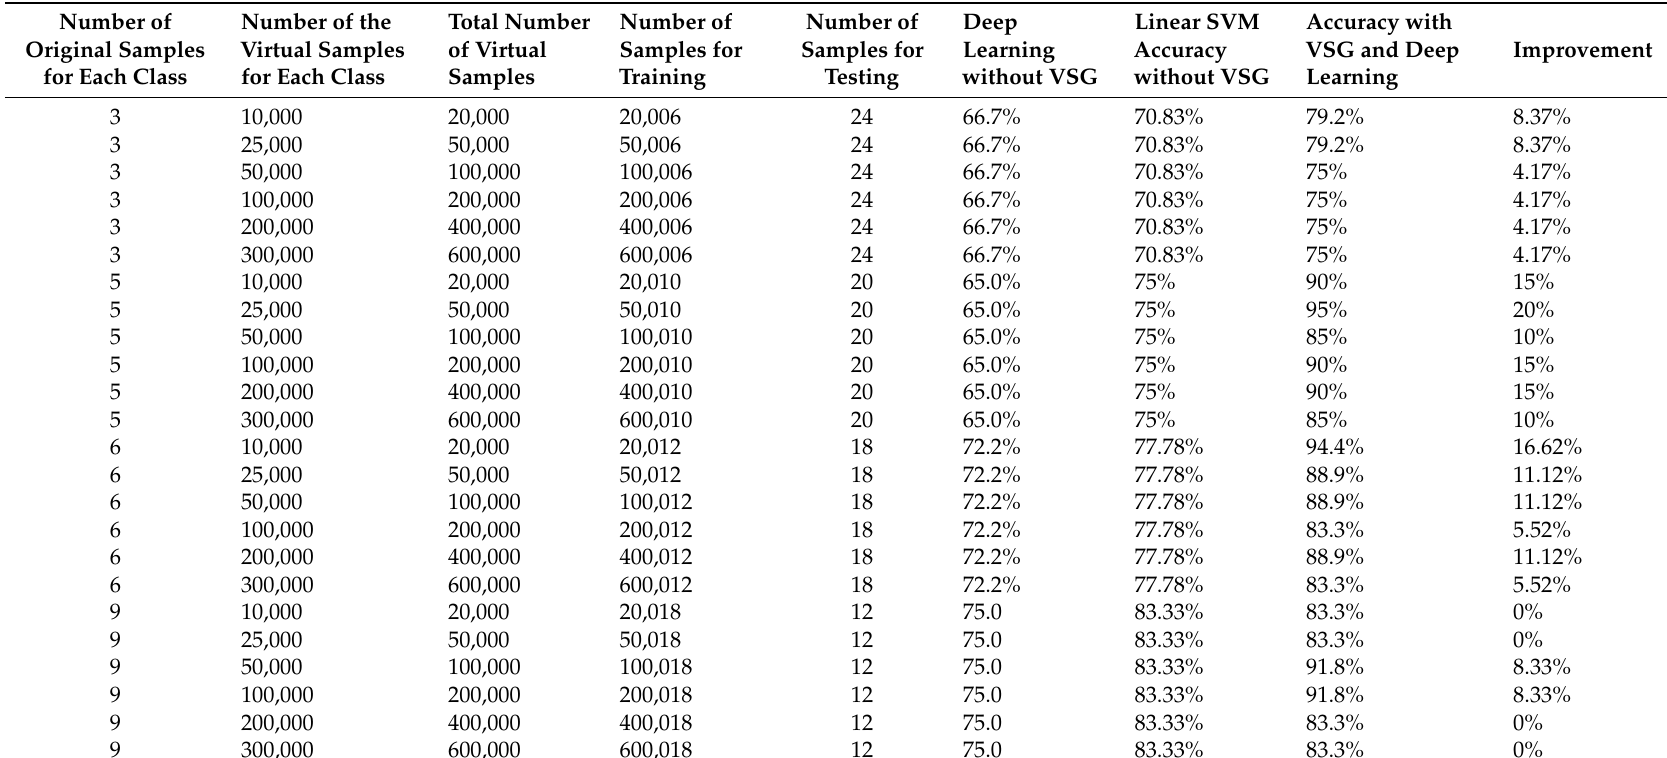
Table 2. The results of the average accuracy using the IRCCS Medea